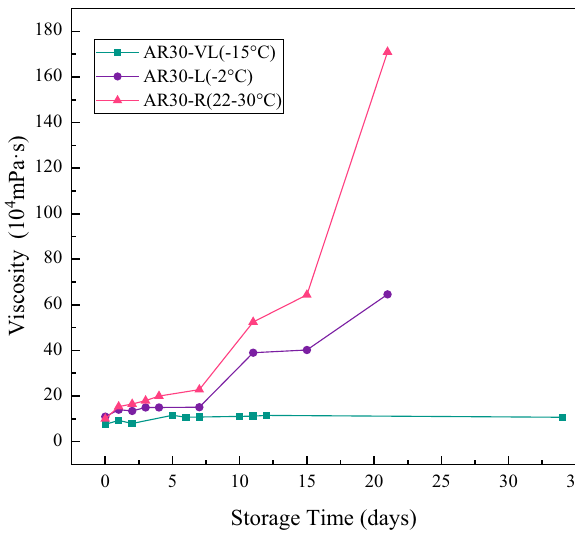
Figure 8: E ff ect of storage temperature on the viscosity of the RTV and fumed silica mixture.